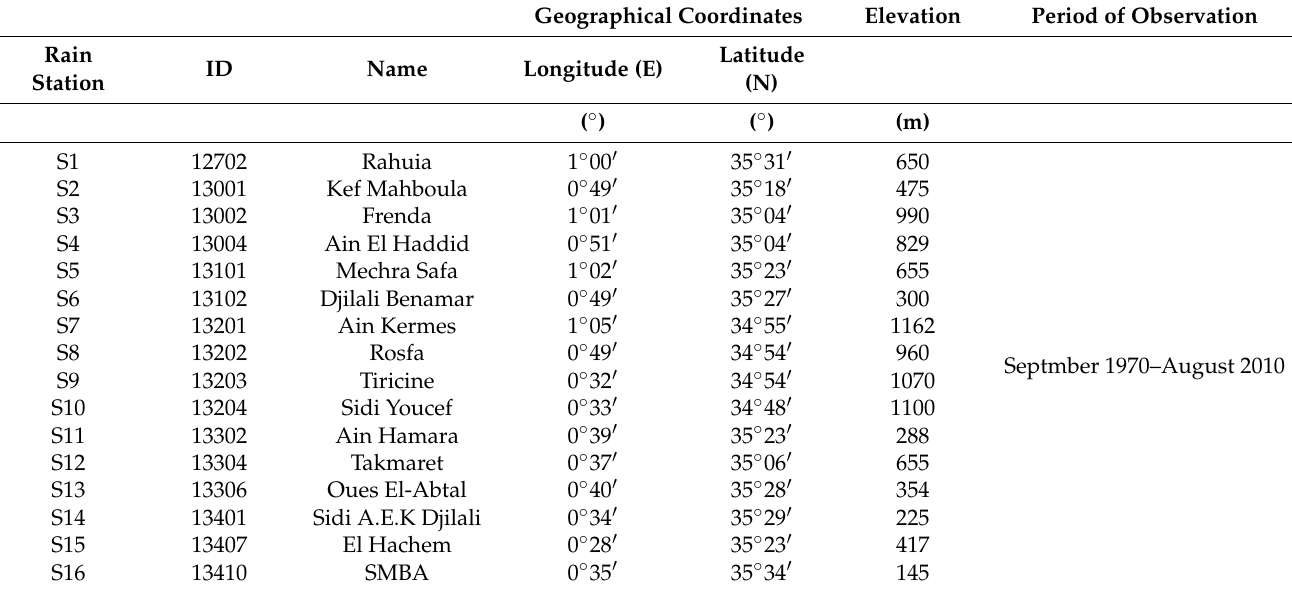
Table 1. Characteristics of rain gauge stations used in the analysis. Geographical Coordinates Elevation Period of Observation